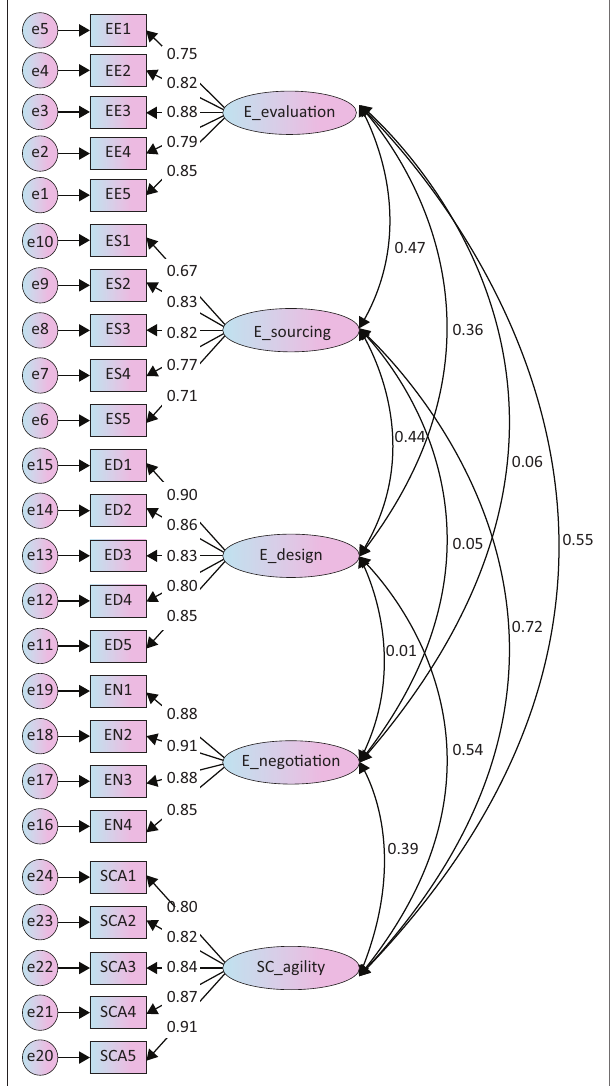
FIGURE 2: The measurement